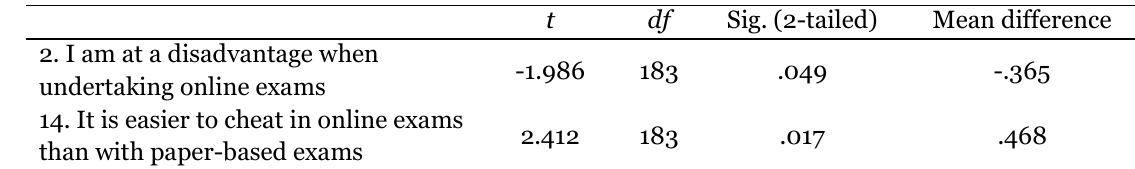
Results of the Independent Samples T -test on Kyrgyz Learners’ Perception by